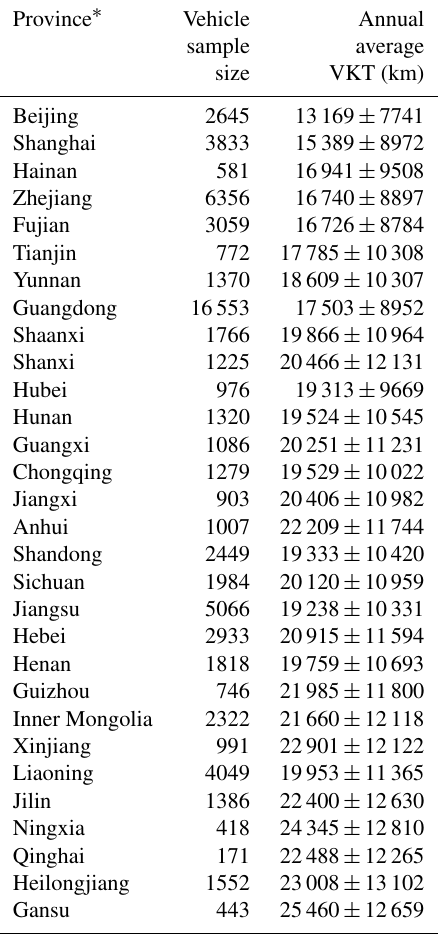
∗ There are no VKT data for Tibet, and we used the national average, which was calculated using the data of the other 30 provinces, to represent the annual VKT of Tibet in this